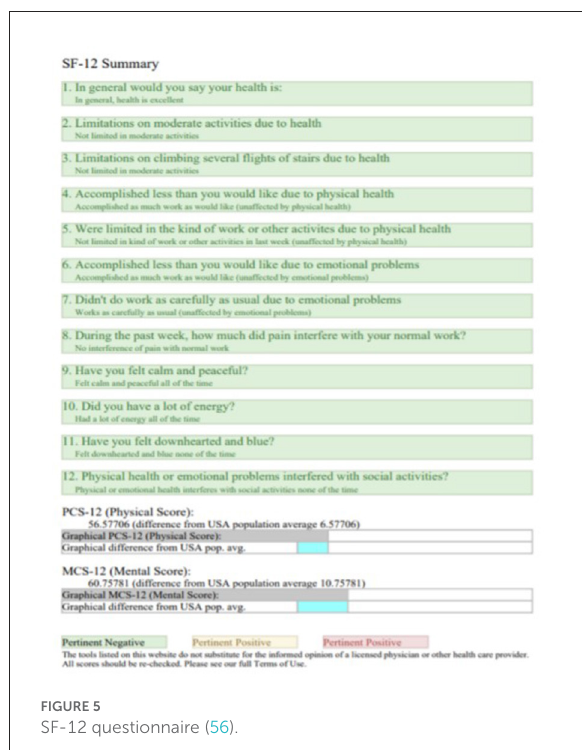
FIGURE5 SF-12 questionnaire